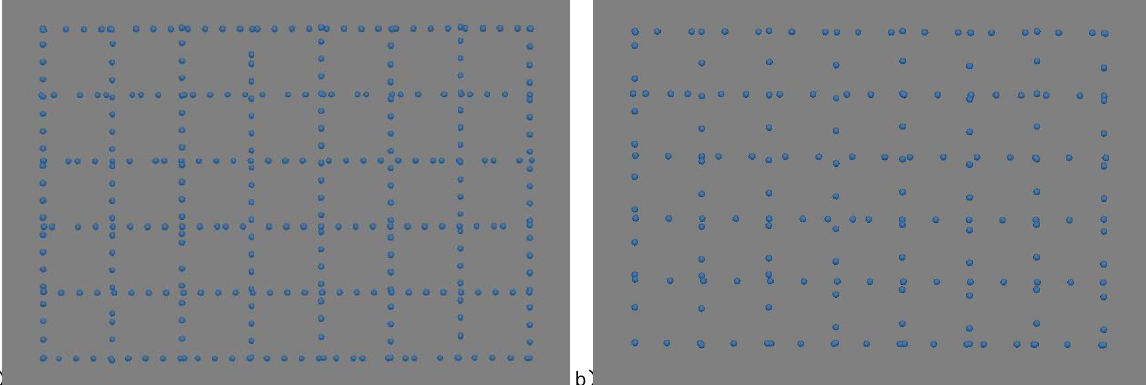
Figure 7. Image block of the double-grid flight before (a) and after (b) filtration. Before